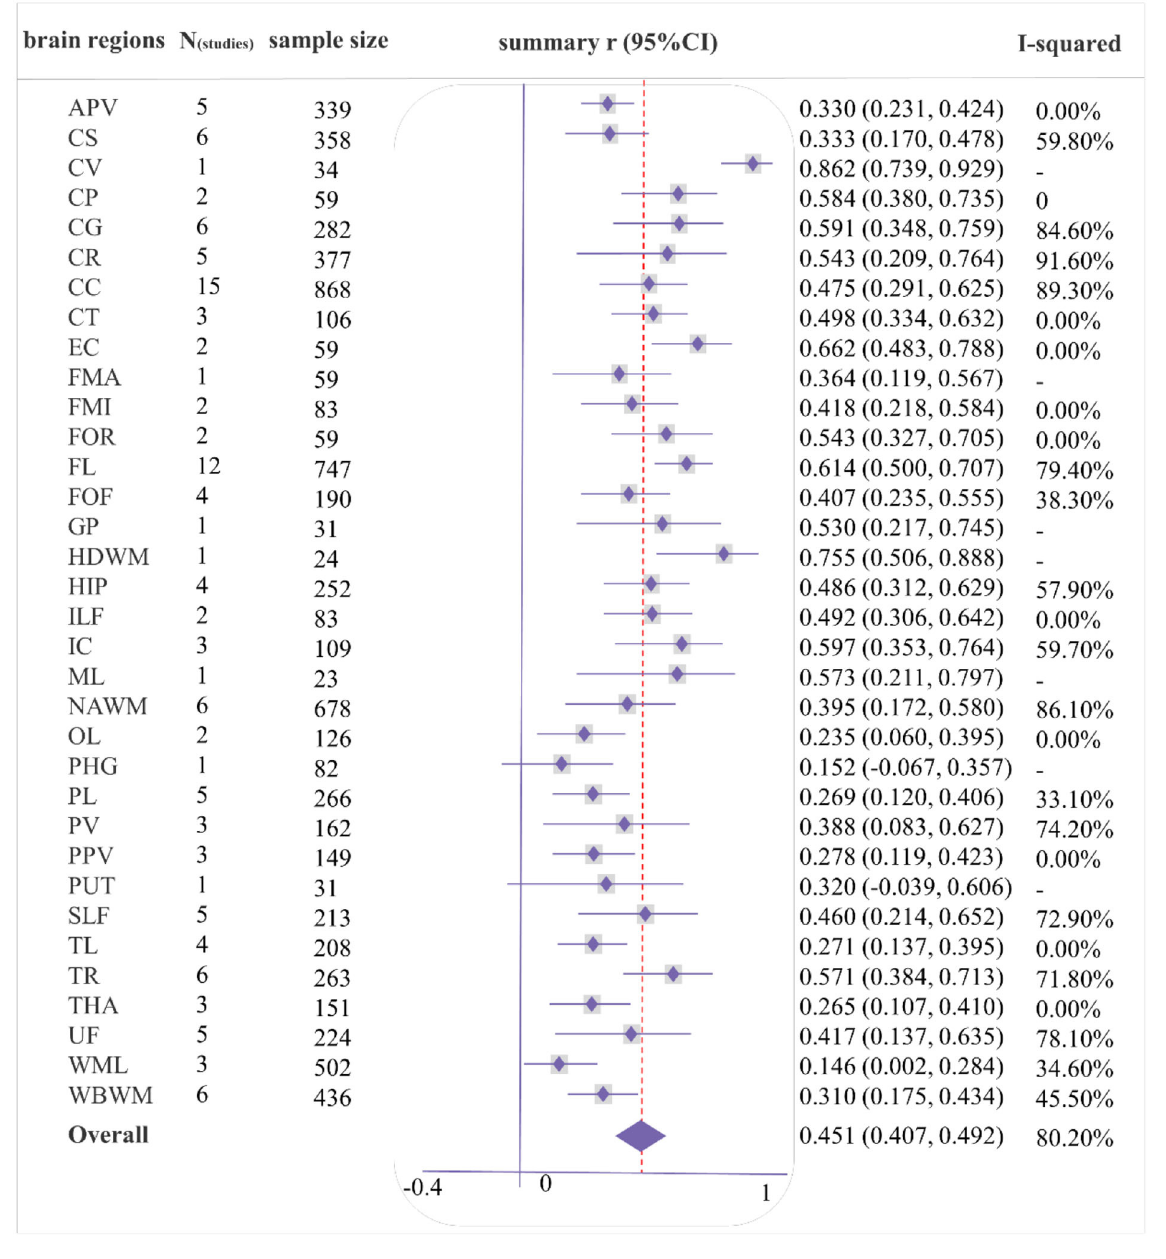
studies, with a total sample size of 155, and only one high-quality study was included. function was − 0.332 ( − 0.382, − 0.280), I 2 = 71.6%